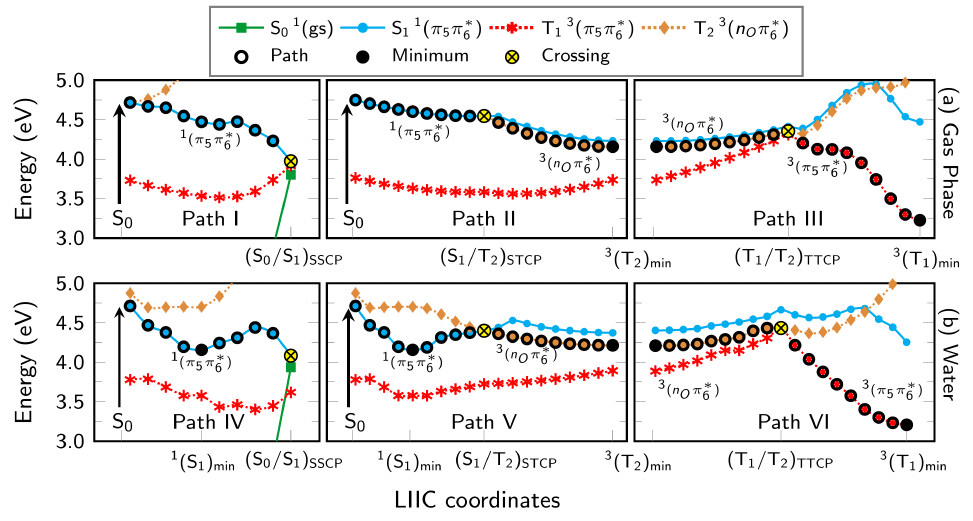
Figure 3. Linear interpolation in internal coordinates defined via Z-Matrix deactivation pathways in ( a ) gas phase and ( b ) water. For each LIIC interpolated structure, a single-point energy calculation at the MS(3S,3T)-CASPT2(12,9)/cc-pVDZ level of theory was carried